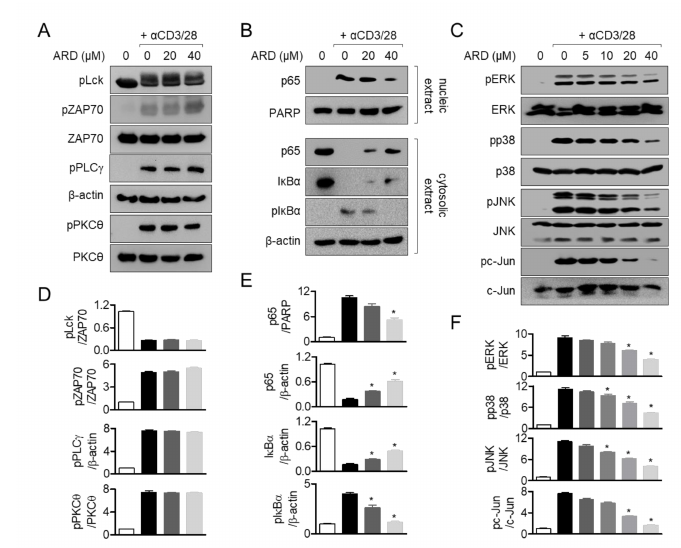
Figure 7. Aromadendrin suppresses p65 translocation and the MAPK but not proximal pathway. ( A ) The phosphorylated protein levels of activated Jurkat T cells pre-treated for 10 min with 20 or 40 µ M of aromadendrin were assessed by Western blotting. ( B ) p65 translocation into nucleus was detected by Western blotting using activated Jurkat T cells pre-treated for 1 h with 20 or 40 µ M of aromadendrin. ( C ) The phosphorylated protein levels of activated Jurkat T cells pre-treated for 30 min with 20 or 40 µ M of aromadendrin were assessed by Western blotting. ( D – F ) The mean values ± SEM of each protein indicated are presented in the bar graph. * p < 0.05, versus the cells activated by anti-CD3 / CD28 antibodies.